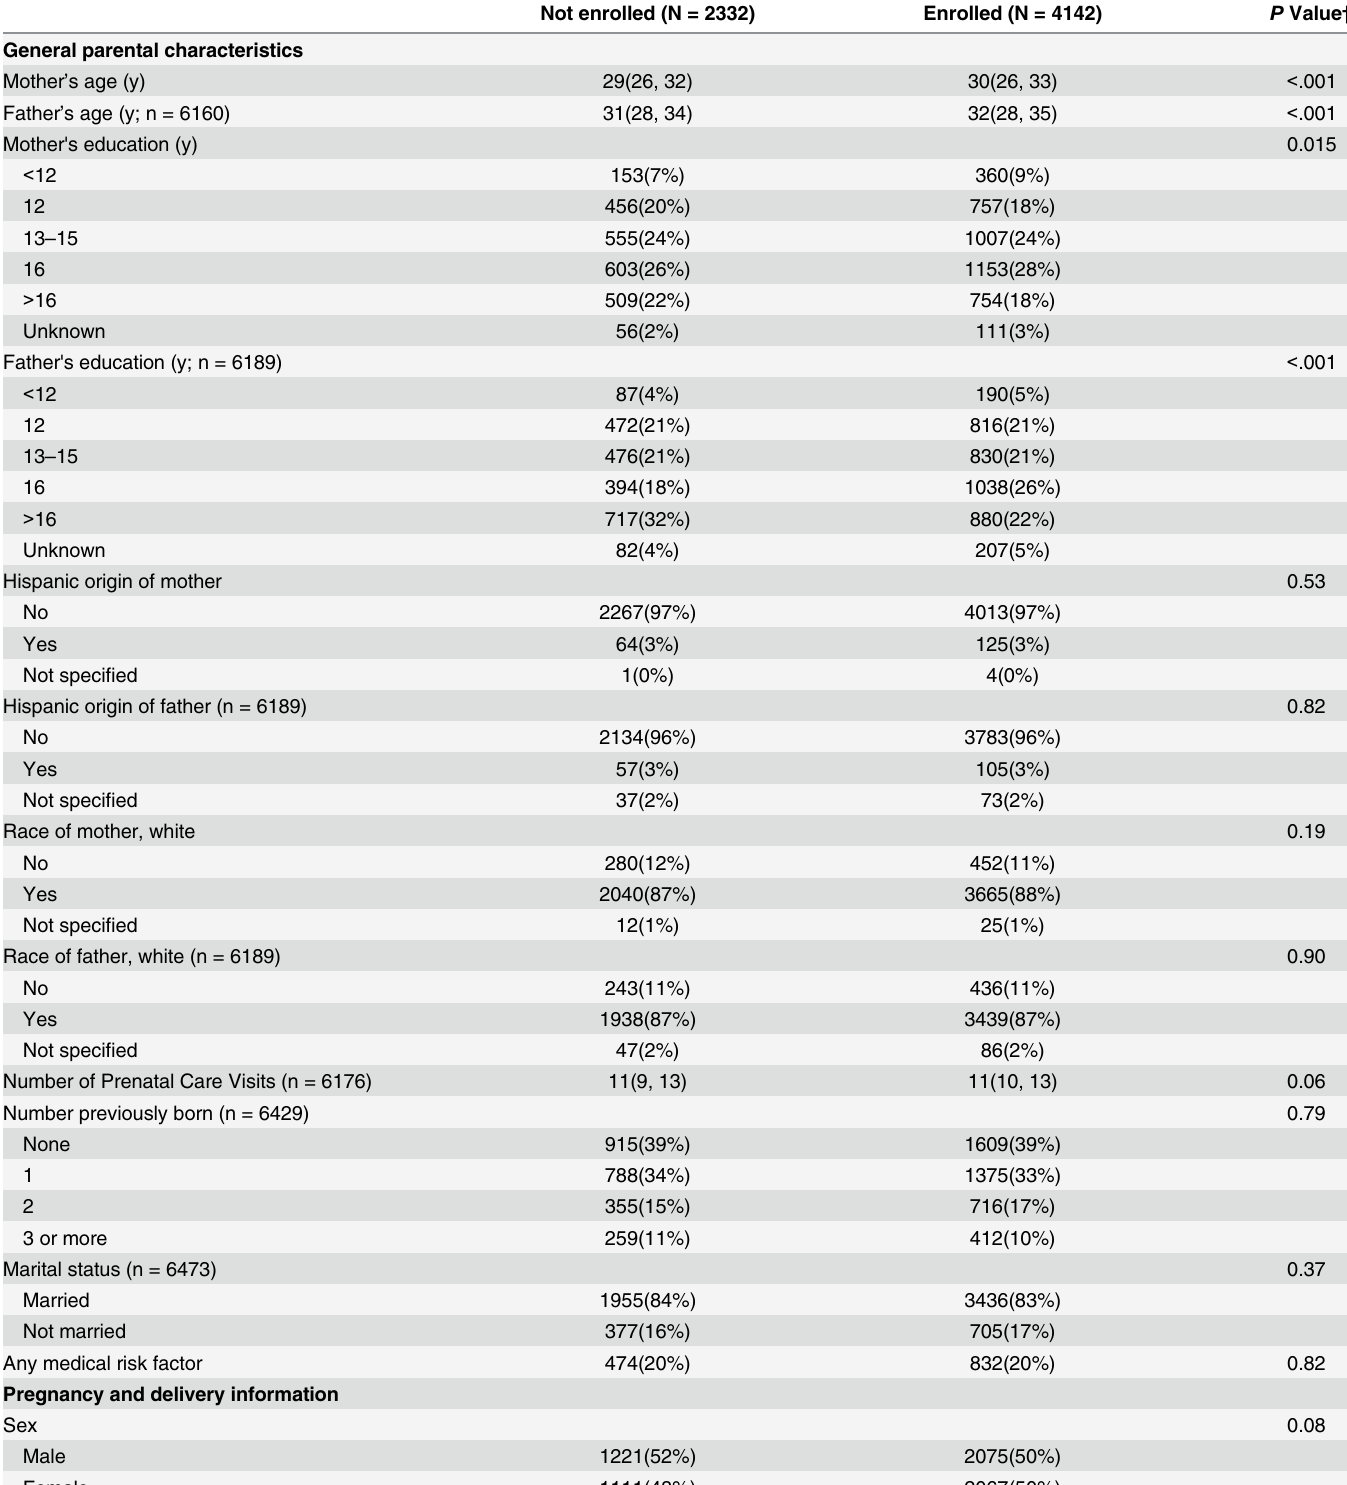
Table 1. Characteristics of children in 1996 – 2000 birth cohort who were and were not enrolled in ISD 535 (n = 6474).